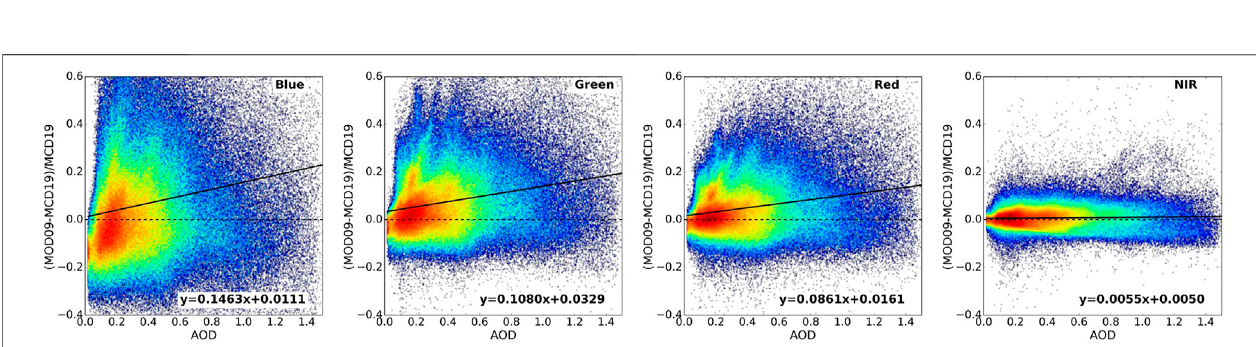
FIGURE 10 | A relative difference ( MCD19-MOD09)/MCD19 in the Blue, Green, Red and NIR bands as a function of MAIAC AOD 0.47 for the Northern China tile H27V05.